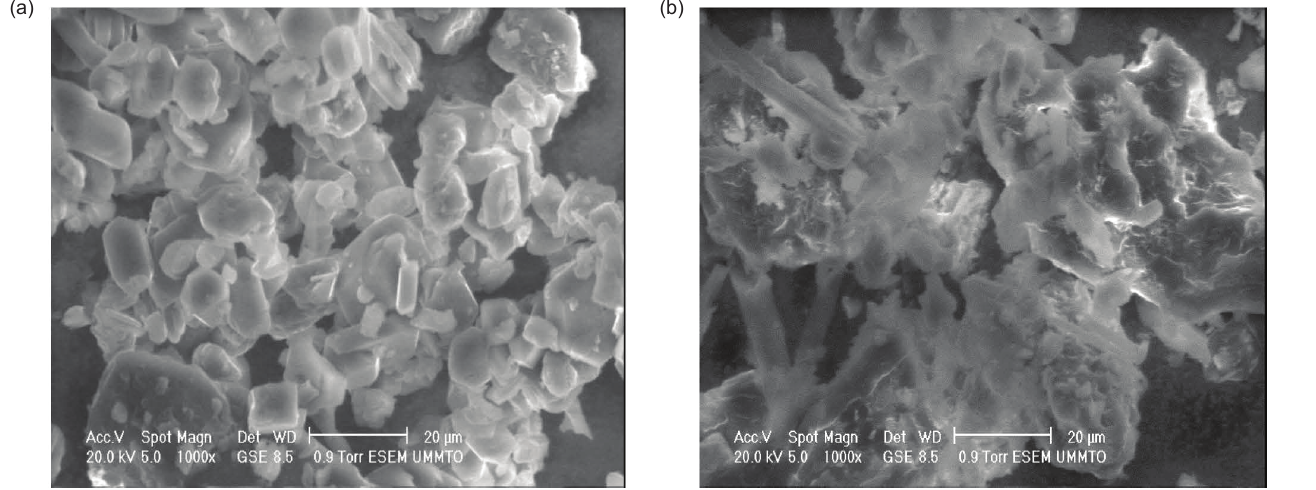
Fig. 7 – SEM images of Oxalis (a) before adsorption of SR 3BL; (b) after adsorption of SR 3BL